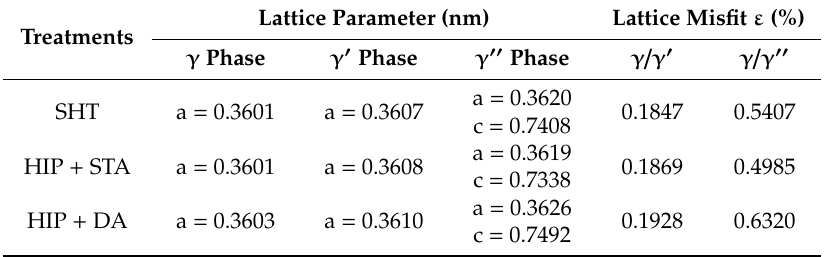
Figure 6. X-ray diffraction analysis of the SHT, HIP + STA, and HIP + DA Inconel 718 superalloys: ( a ) full XRD pattern; ( b – d ) deconvolutions of the diffraction peak 3 of the SHT, HIP + STA, and HIP + DA Inconel 718 superalloys, respectively. Table 2. Lattice parameters and misfits for the standard heat treatment (SHT), hot isostatic pressing